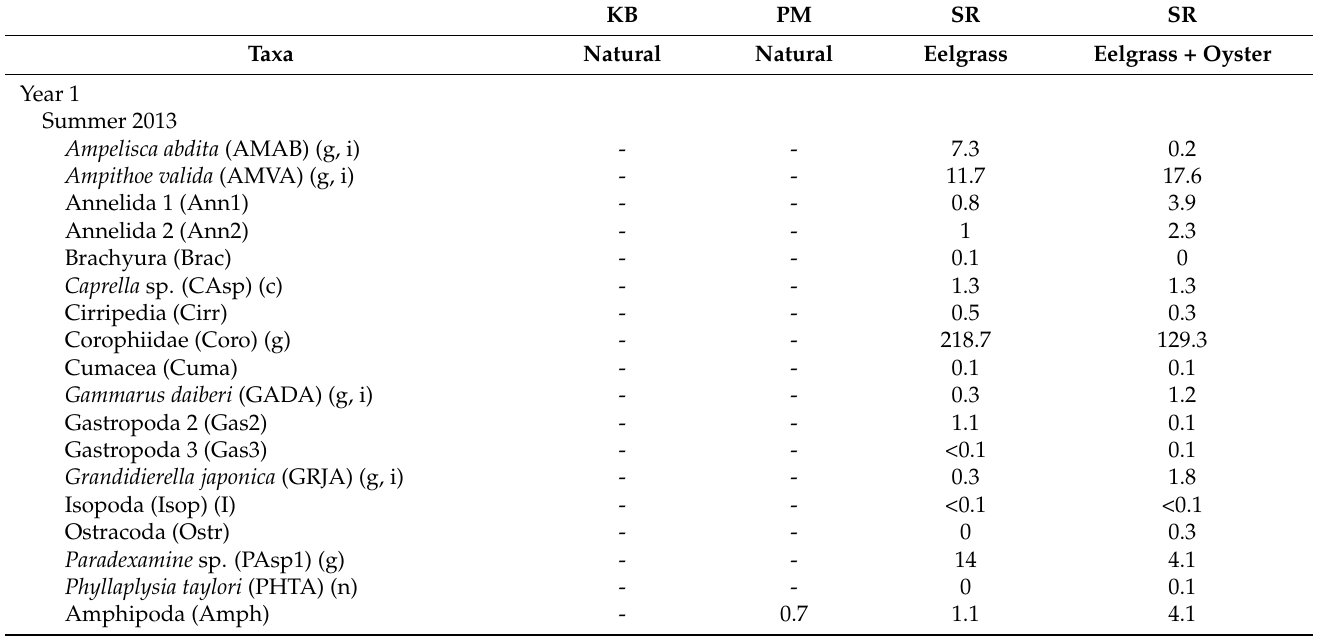
Table A3. Invertebrate community composition and mean abundance per collected shoot at all sites and years. Letters represent family and order (c = caprellid, g = gammarid, I = isopod), and native (n), introduced (i), or cryptogenic (c). See Figure 1 for site